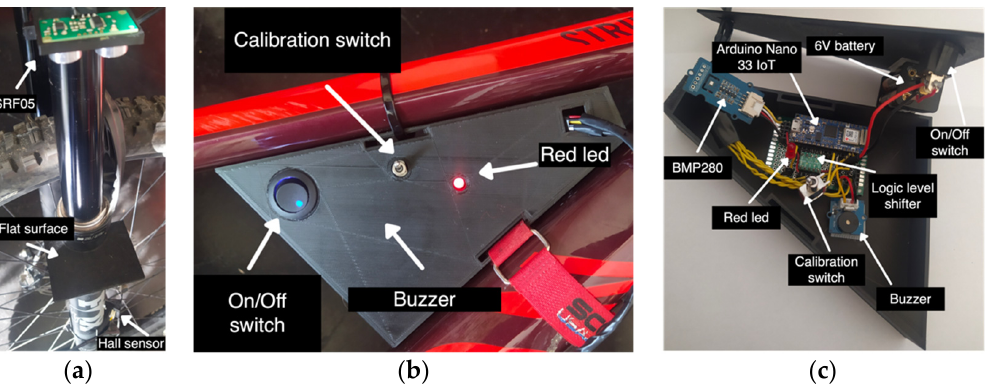
Figure 12. The smart bike main components: ( a ) the front fork with the ultrasonic sensor and the hall sensor; ( b ) the main core of the system, including a led and a buzzer to check if the system is running correctly; ( c ) the inside of the core, where the Arduino board is installed, and a battery powers the system.